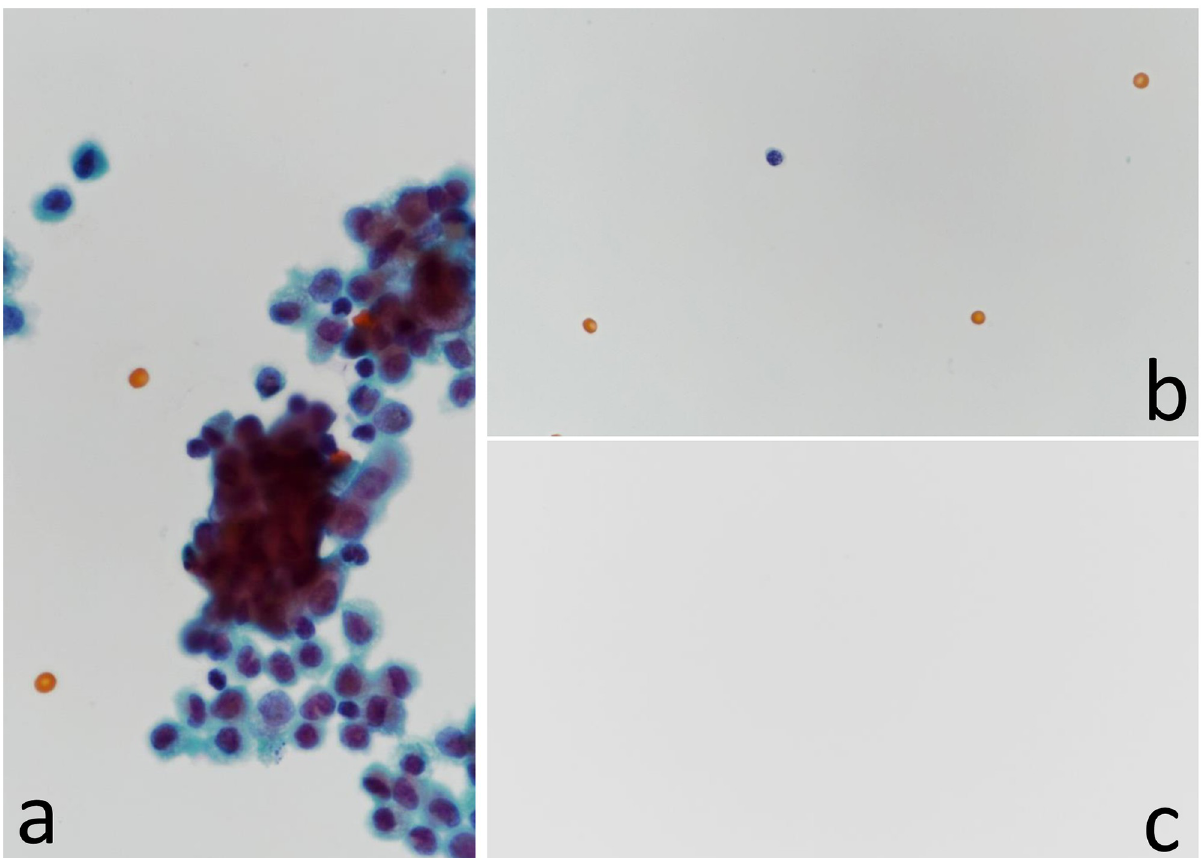
Fig 3. Microscopic findings of cell transit test. (A) Dense fluid (1.0 × 10 6 cells/mL) stained with Papanicolaou (original magnification × 400). Mesothelial cells, various inflammatory cells, and erythrocytes can be seen. (B) Filtrate with a single-layered sheet (original magnification × 400). One nucleated cell is detected with three erythrocytes. (C) Filtrate with three-layered sheets (original magnification × 400). A complete absence of cells and erythrocytes can be seen.